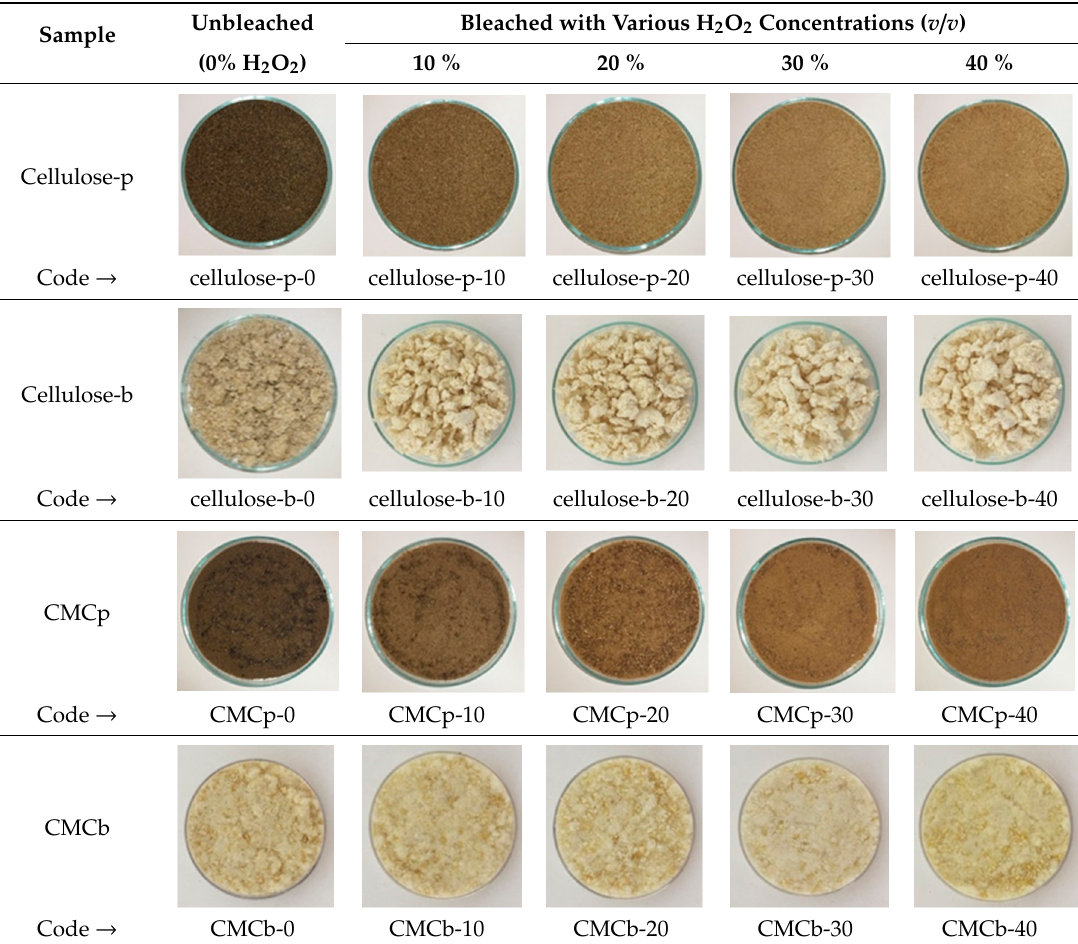
Table 1. Appearance of cellulose and CMC from palm bunch and bagasse in different conditions.